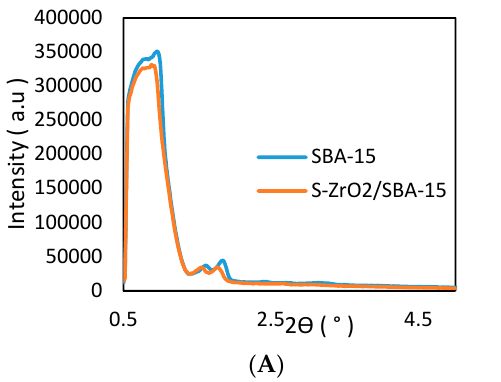
Table 5. Analysis of variance (ANOVA) for the linear model.